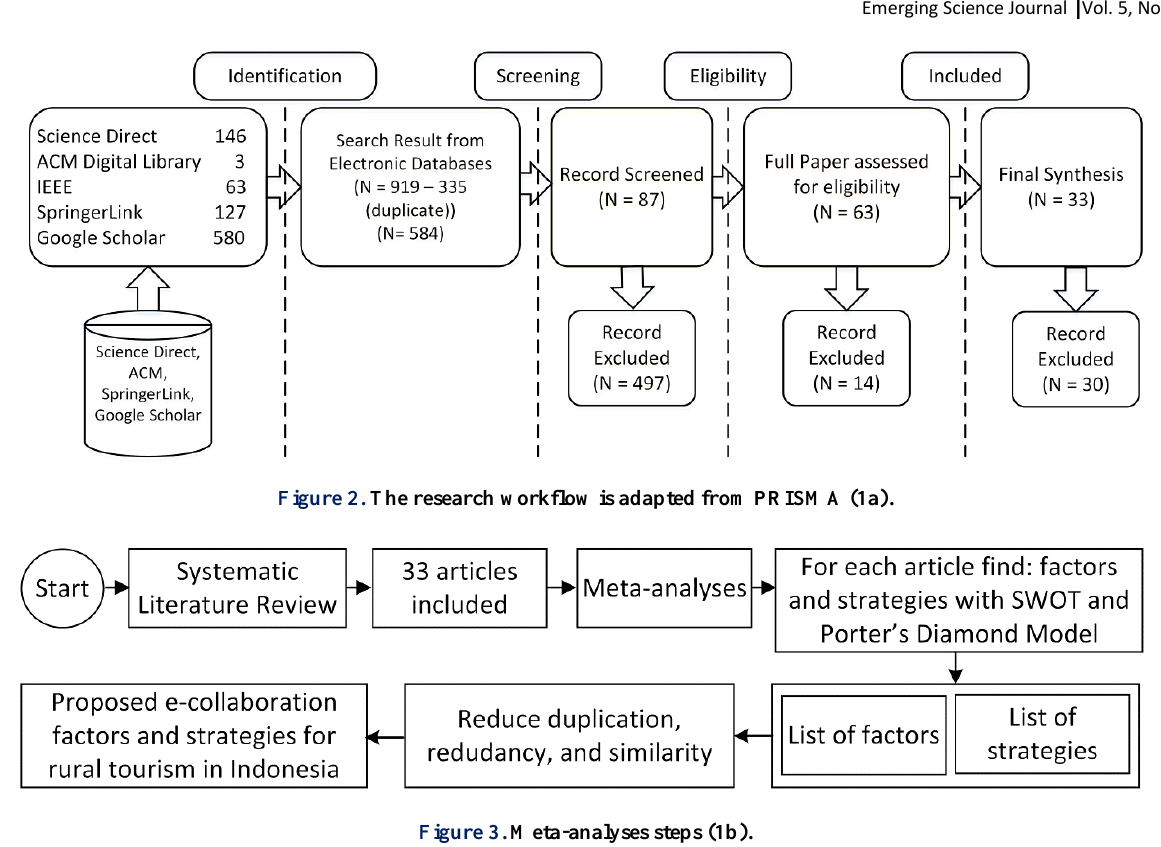
Figure 3. Meta-analyses steps